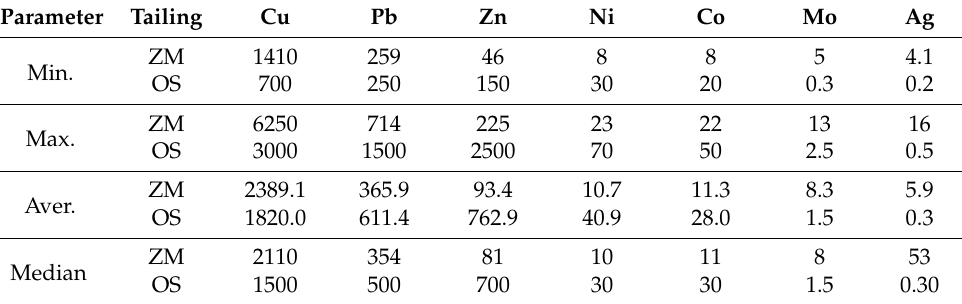
Table 1. Minimum values, maximum values, averages, and median parameters for ZM and OS (on the basis of data from Tables S1 and S2 in Supplementary